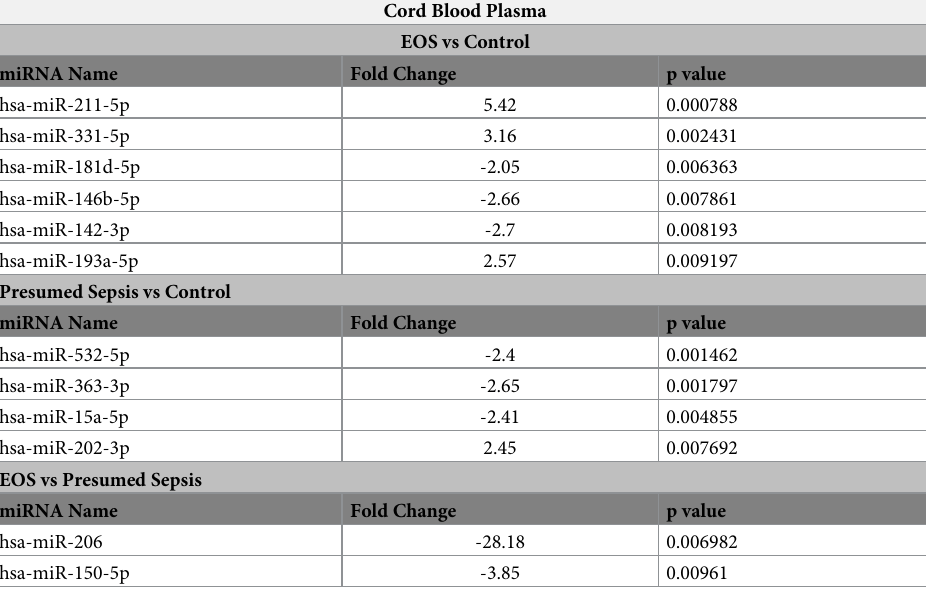
Table 2. Top miRNA differences between groups–cord blood